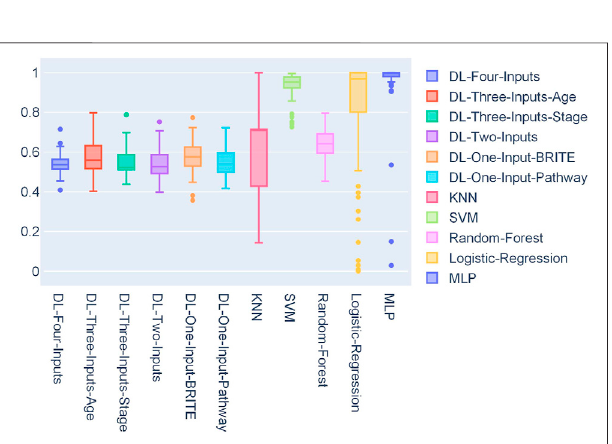
FIGURE 5 | Box plot of the distribution of 50 thresholds for each model on the TCGA lung cancer data